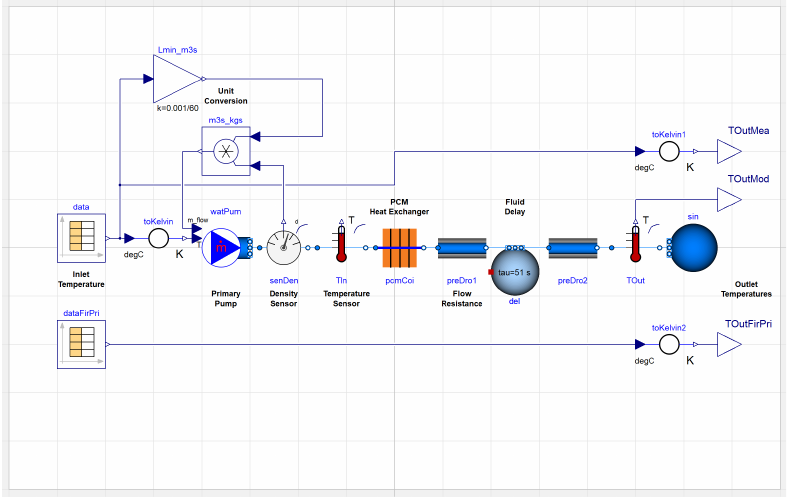
Figure 6. Full model of the thermal energy storage test rig in